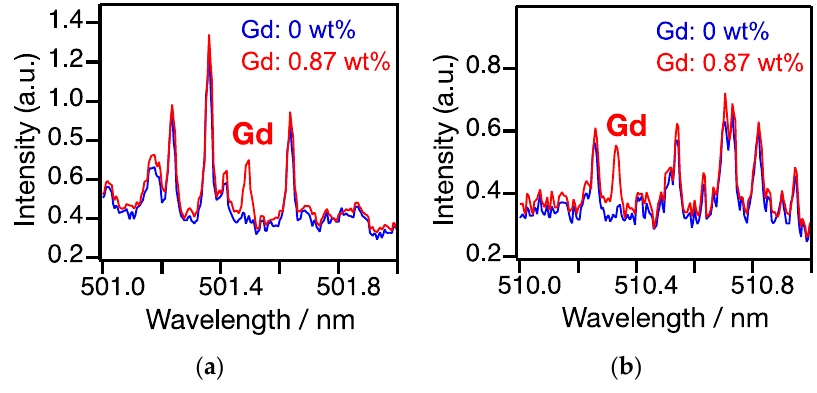
Figure 4. Emission spectra of surrogate nuclear fuel debris in the neighborhood of Gd lines at ( a ) 501.5 nm and ( b ) 510.3 nm.